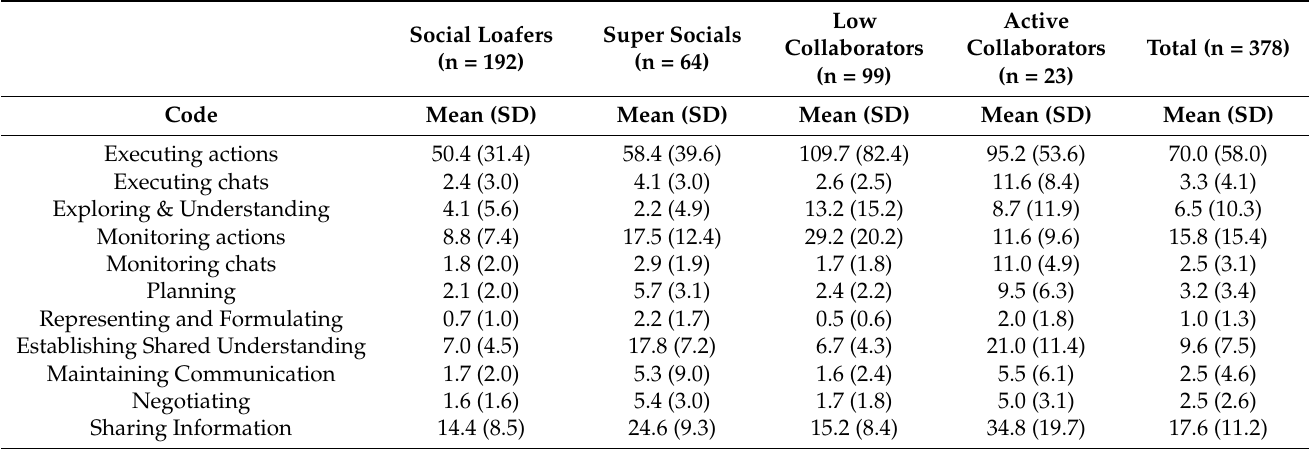
Table 5. Descriptive statistics for average frequencies of automated CPS codes for each cluster and overall. Social